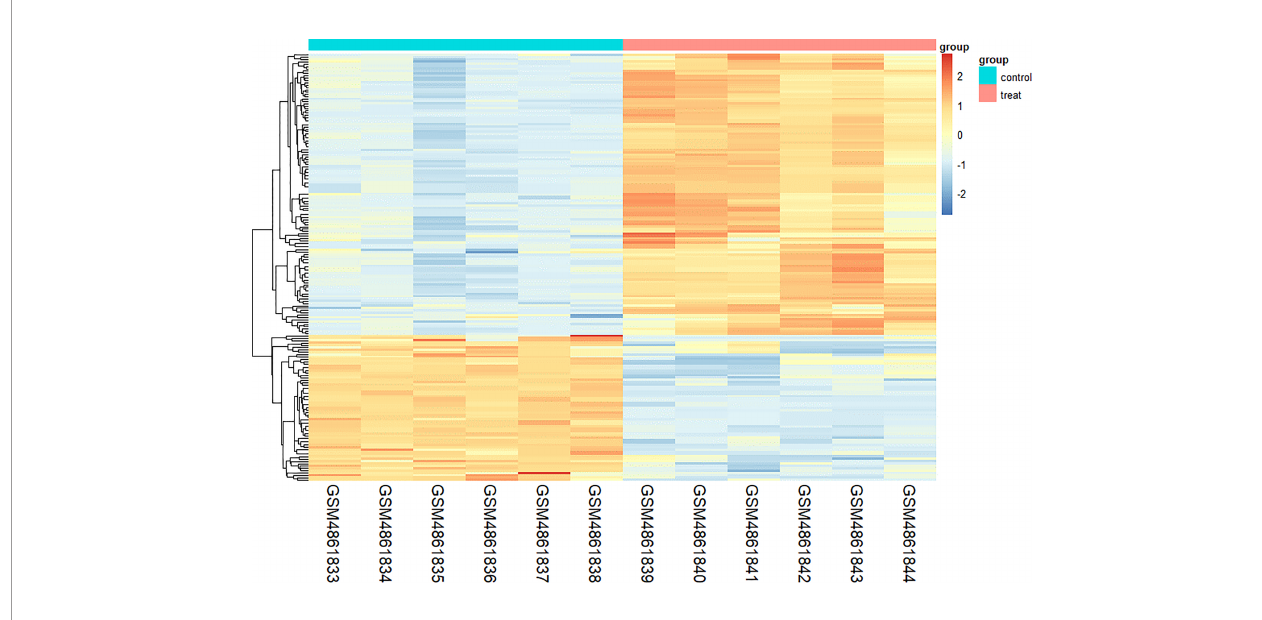
FIGURE 2 | Heat map of